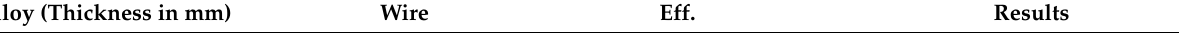
Table 5. Overview of results achieved in LBW and LAHW of Al alloys. Here, Eff. means WM to BM strength ratio in %, (aw—means as welded condition, pw—post-weld heat treatment). Alloy (Thickness in mm) Wire Eff.